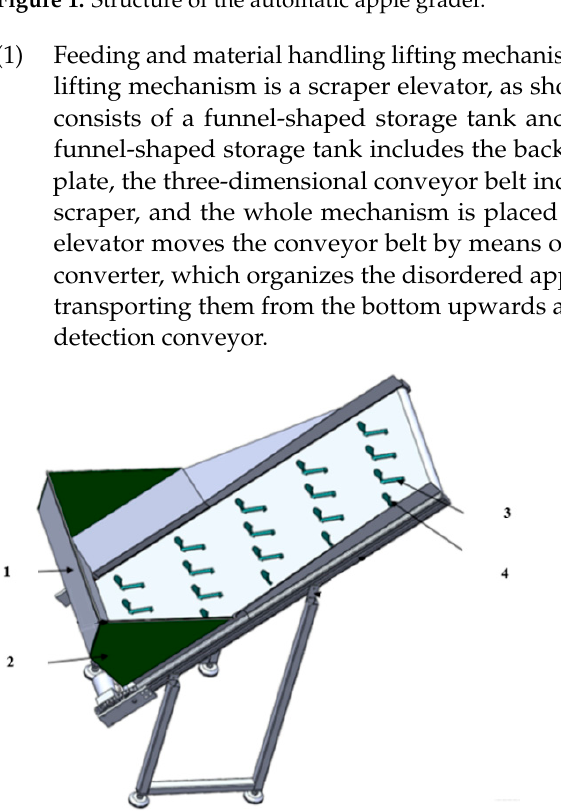
Figure 1. Structure of the automatic apple grader.